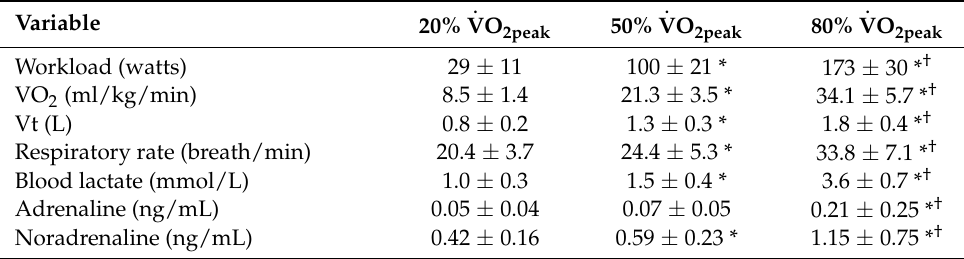
Table 1. The physiological parameters during